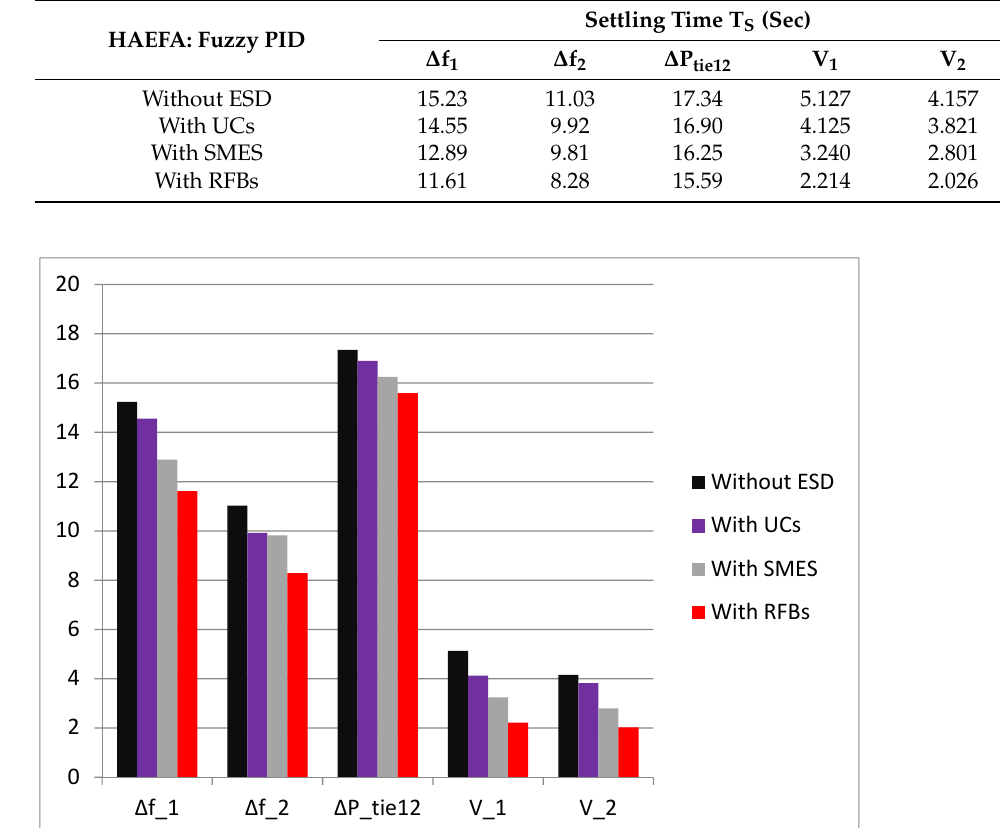
Figure 11. Comparison of responses’ settling time (in seconds on Y-axis) for different ESDs.